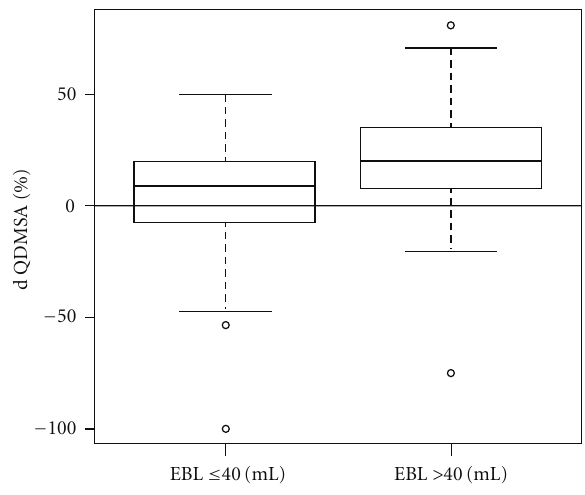
Figure 1: Mean change of postoperative renal function of the operated kidney as measured by QDMSA stratified according to intraoperative estimated blood loss ( P = 0 .